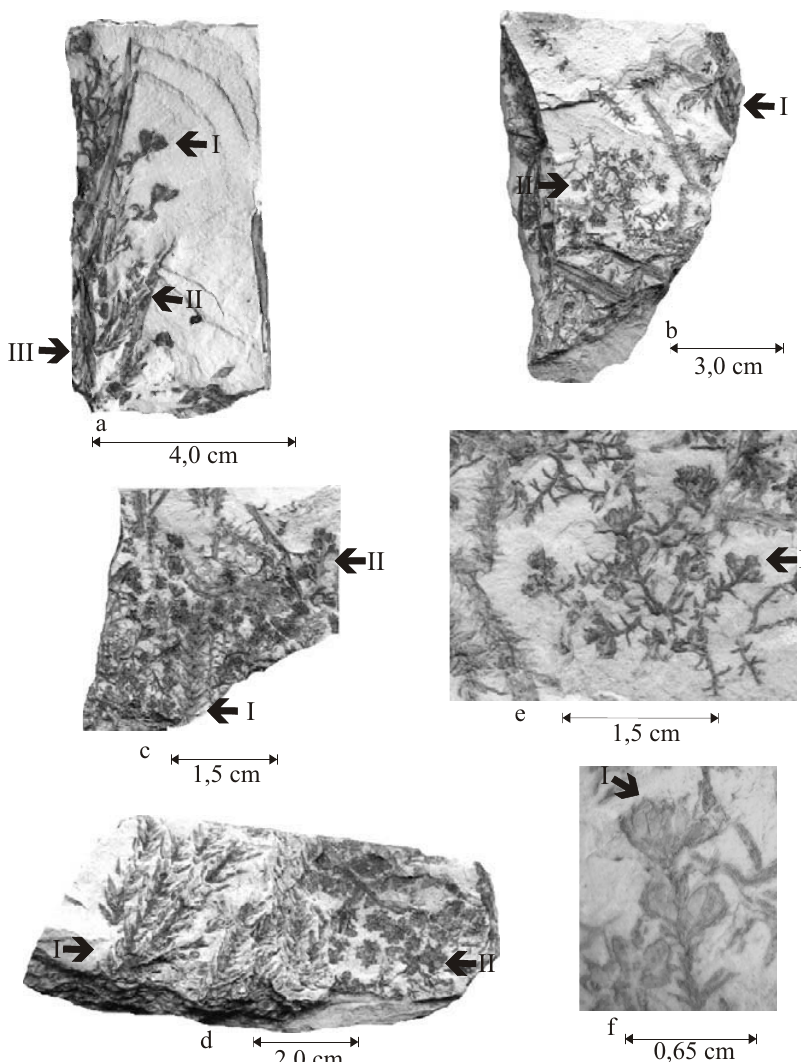
Fig. 5 – Coricladus quiteriensis sp. nov. reproductive branches from Quitéria outcrop: (a) reproductive (I) and vegetative (II) branches, coming from the same leafless principal branch (III) – PbU 073; (b) association of vegetative branches (I) and reproductive branches (II) with bracteal scales, associated to ovuliferous scales at the apical portion – PbU 222; (c) association of vegetative branches (I) and reproductive branches (II) with bracteal scales, associated to ovuliferous scales at the apical portion – PbU 190; (d) association of vegetative (I) and reproductive (II) branches – PbU 057; (e) detail from the reproductive (I) branches – PbU 222; (f) detail from the reproductive branches, with the presence of elliptically-elongated seeds in anatropous position (I) – PbU